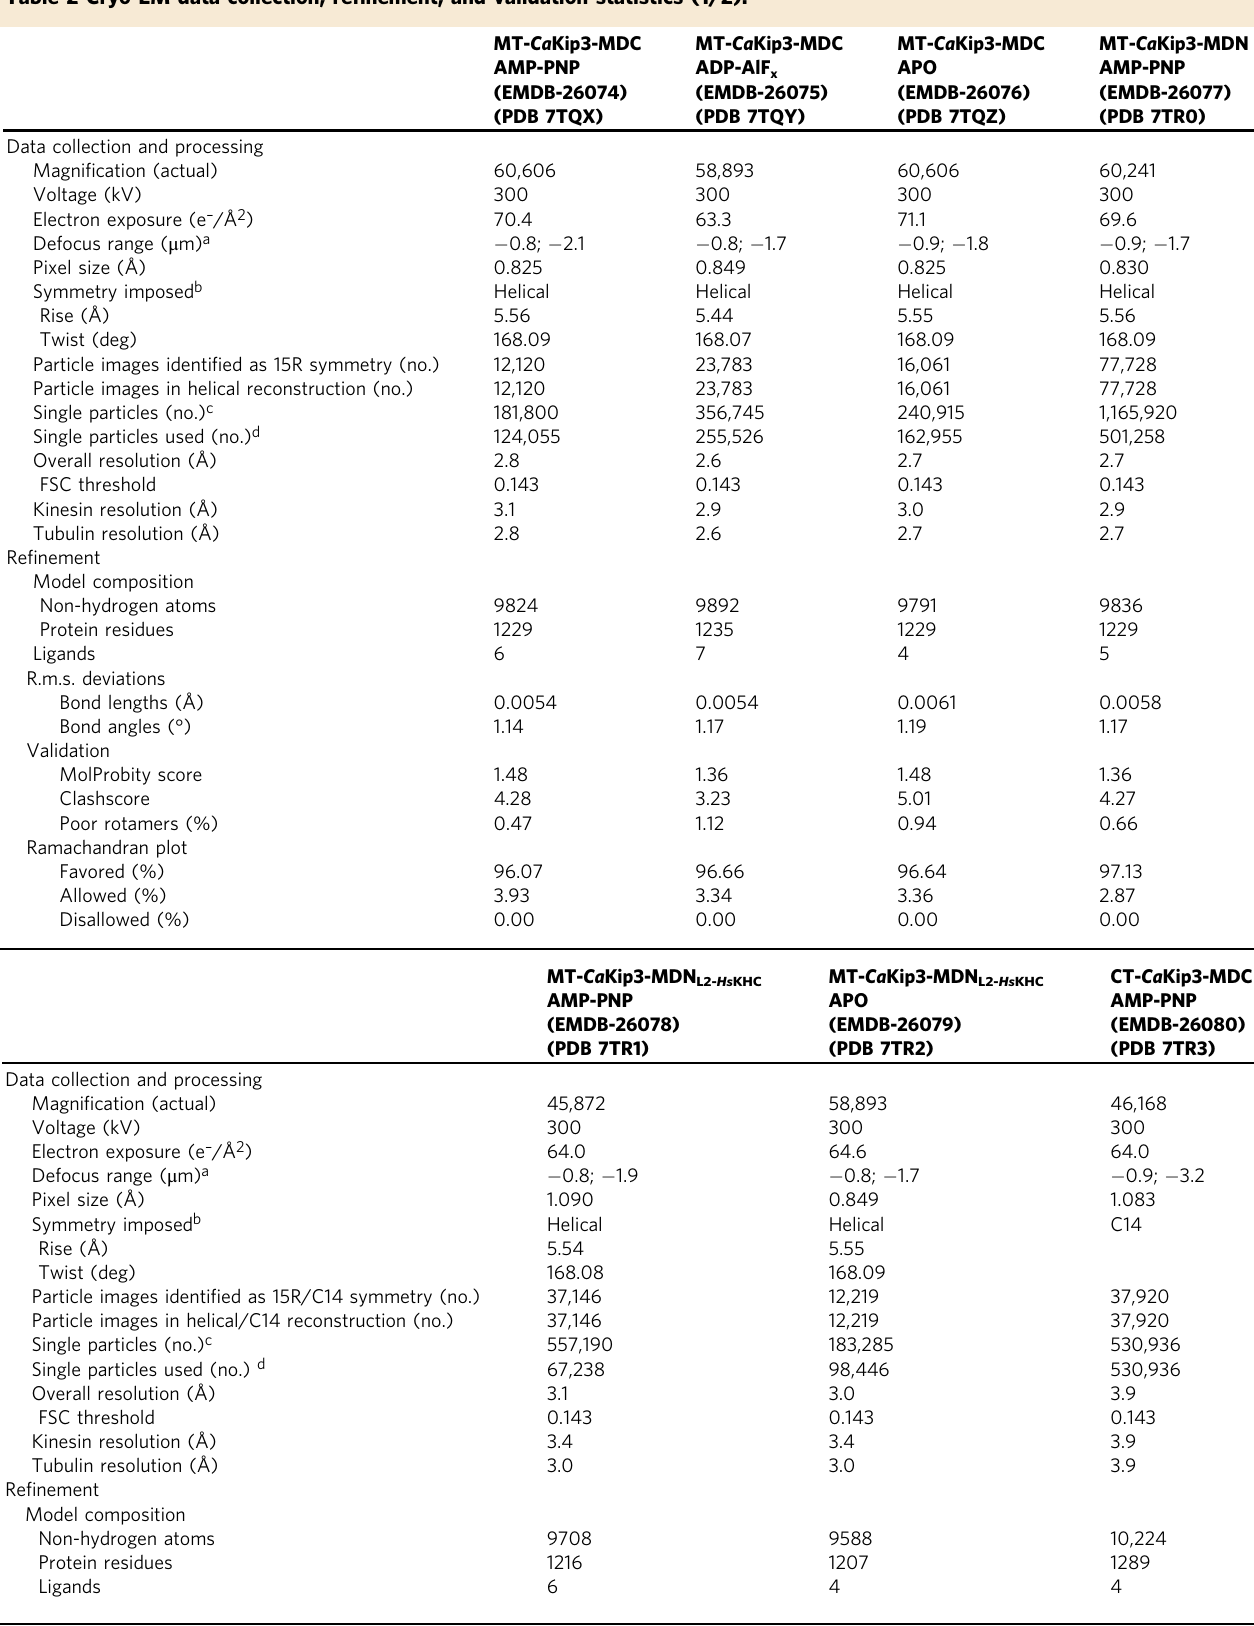
Table 2 Cryo-EM data collection, re fi nement, and validation statistics